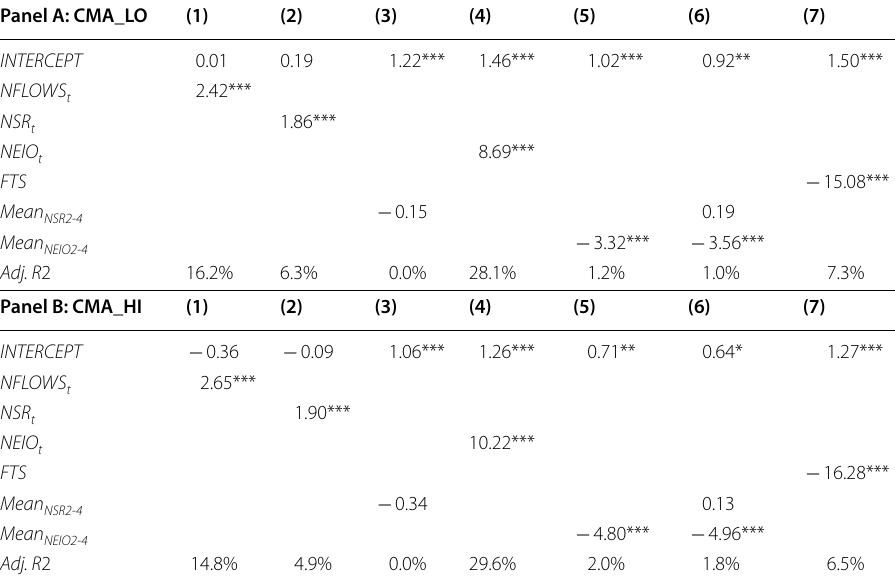
Table 3 Regression of the long and short leg of the CMA factor portfolio on